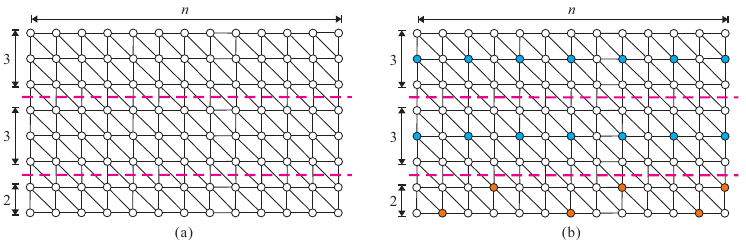
(cid:101) disjoint subgraphs, and ( b ) an (independent) dominat- Figure 13. ( a ) Partitioning of T m × n into (cid:100) m 3 ing set of T m × n . Solid dashed lines indicate separations and filled circles indicate vertices in the (independent) dominating